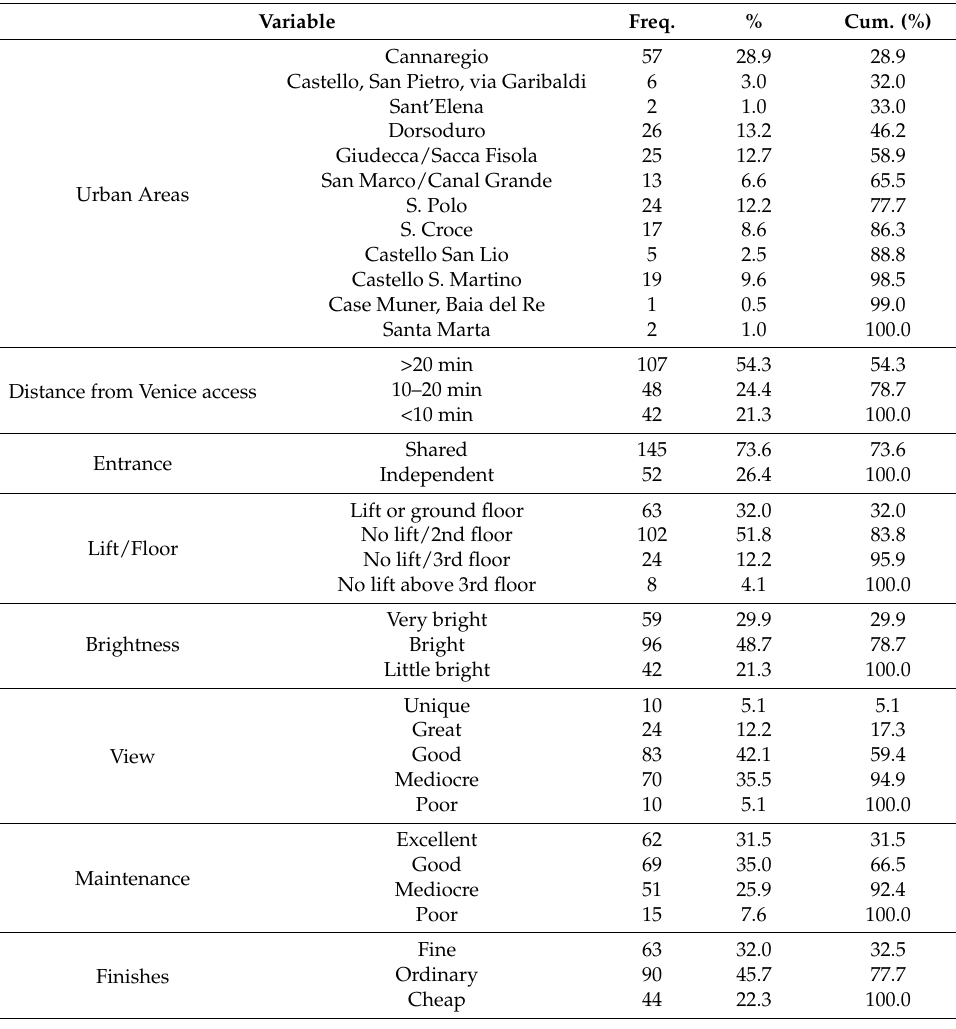
Table 2. Summary of nominal/ordinal variables of the sample.